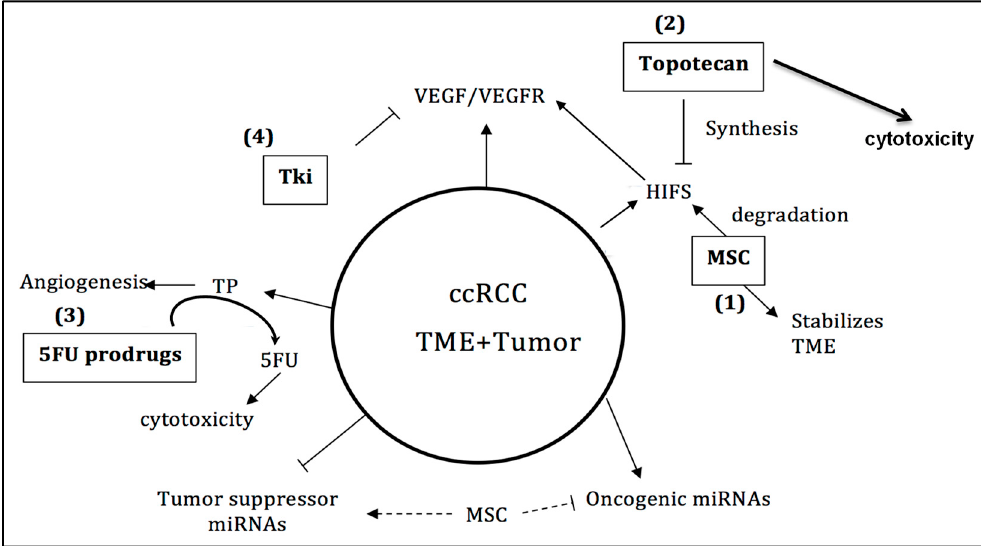
Chart 2. Schematic representation of targetable markers expressed in ccRCC. Methylselenocysteine (MSC) targets hypoxia-inducible factors (HIFs) and micro RNAs (miRNAs). Topotecan targets HIF synthesis, while tyrosine kinase inhibitors (TKIs) target vascular endothelial growth factor (VEGF)/VEGF receptor (VEGFR) and 5-fluorouracil (5-FU) prodrugs are the substrate for activation